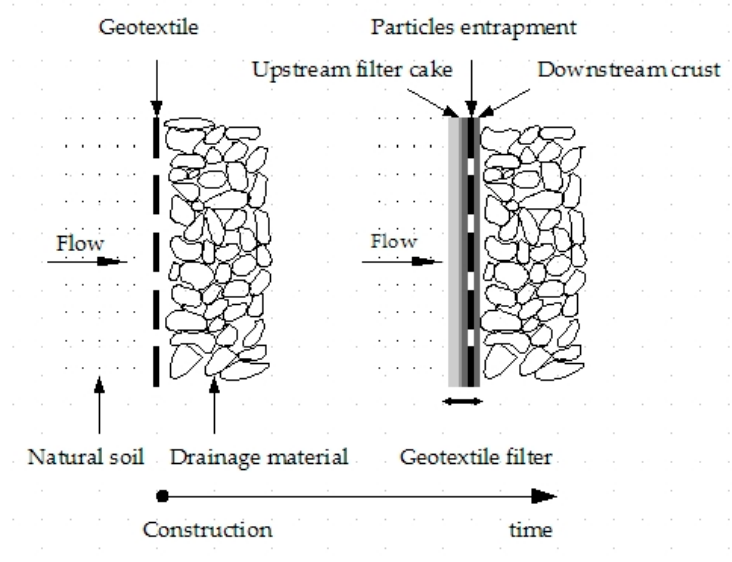
Figure 1. Evolution of a geotextile filter structure over time.